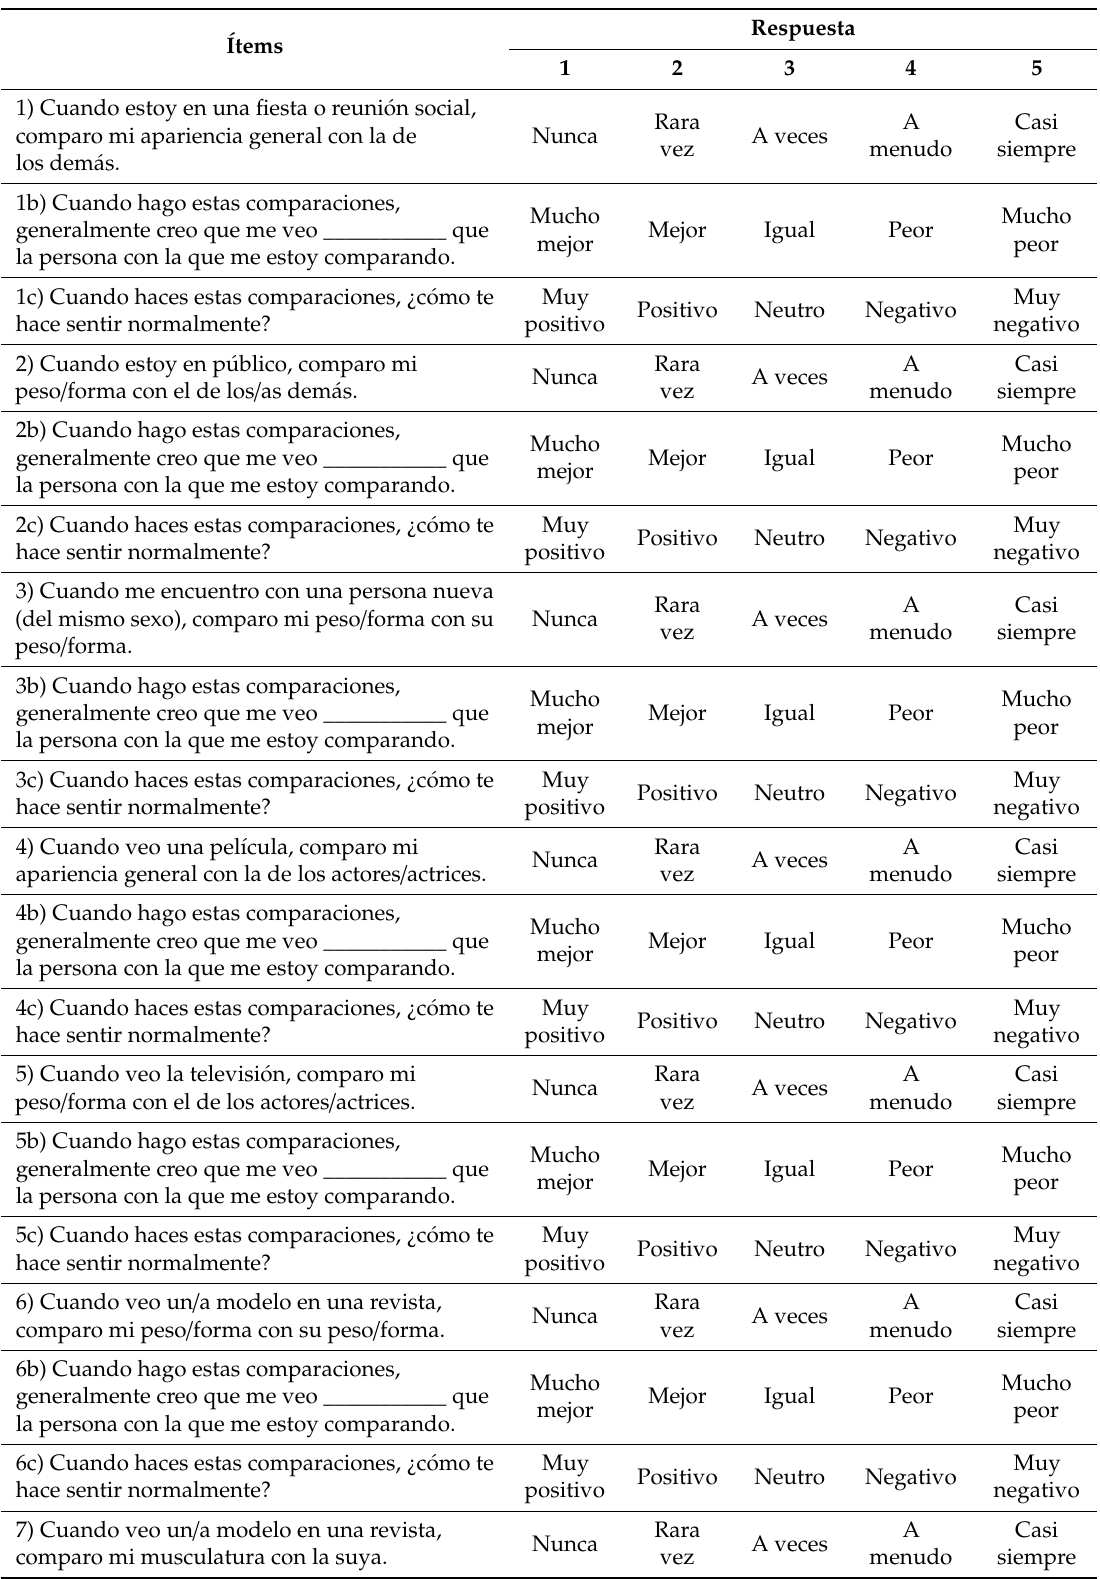
Table A2. Spanish translation of the Physical Appearance Comparison Scale–3 (PACS-3). Í